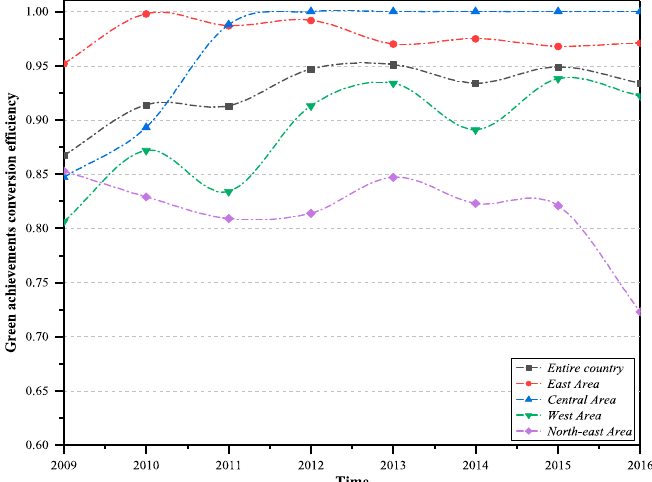
Figure 4. Green technology innovation achievements in transformation efficiency of the country and the four major regions (2009 – 2016).